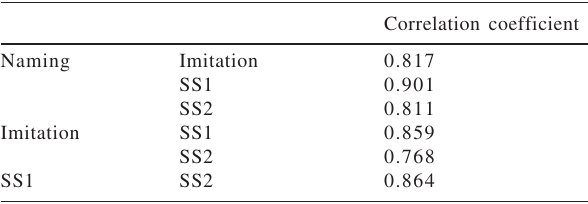
Table 5 - Correlations among the proportions of distortion occurrences in the different tests.